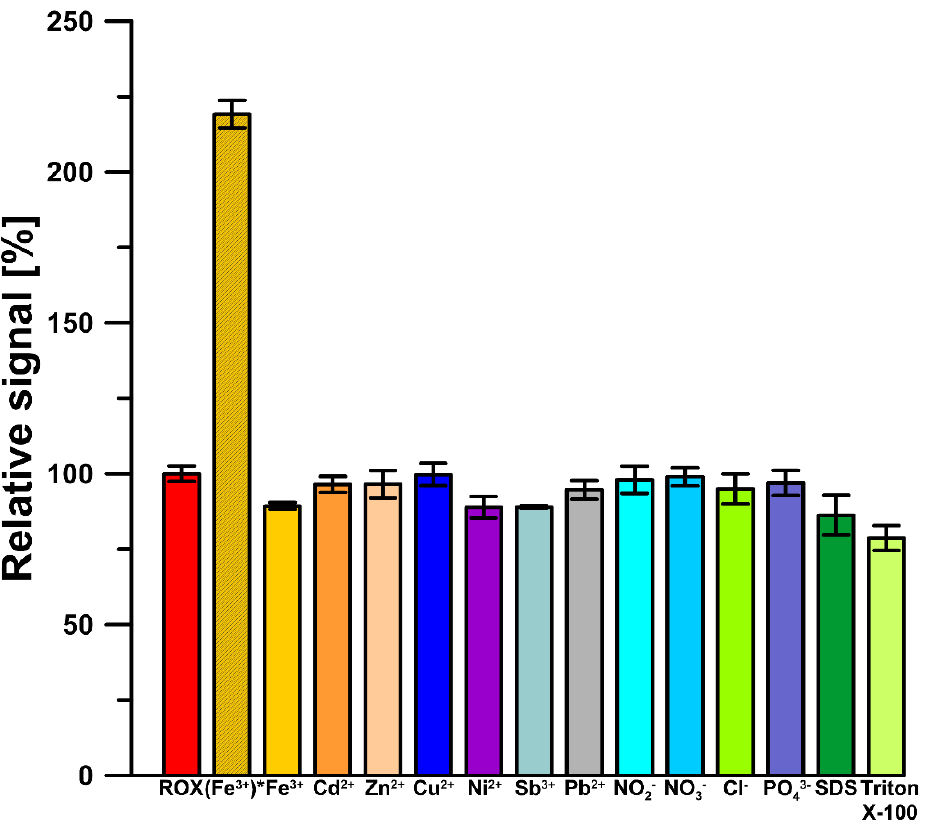
Figure 8. Influence of 10 µM metal ions (Fe 3+ , Ni 2+ , Pb 2+ , Cd 2+ , Zn 2+ , Sb 3+ , Cu 2+ , NO 2- , NO 3- , Cl - and PO 43- ), 10 mg/L SDS and Triton X-100 on the 1 µM ROX signal. (Fe 3+ ) * without DTPA, other metal ions and surfactants in the presence of 10 µM DTPA in supporting electrolyte. The standard devia- tion was calculated for n = 3.